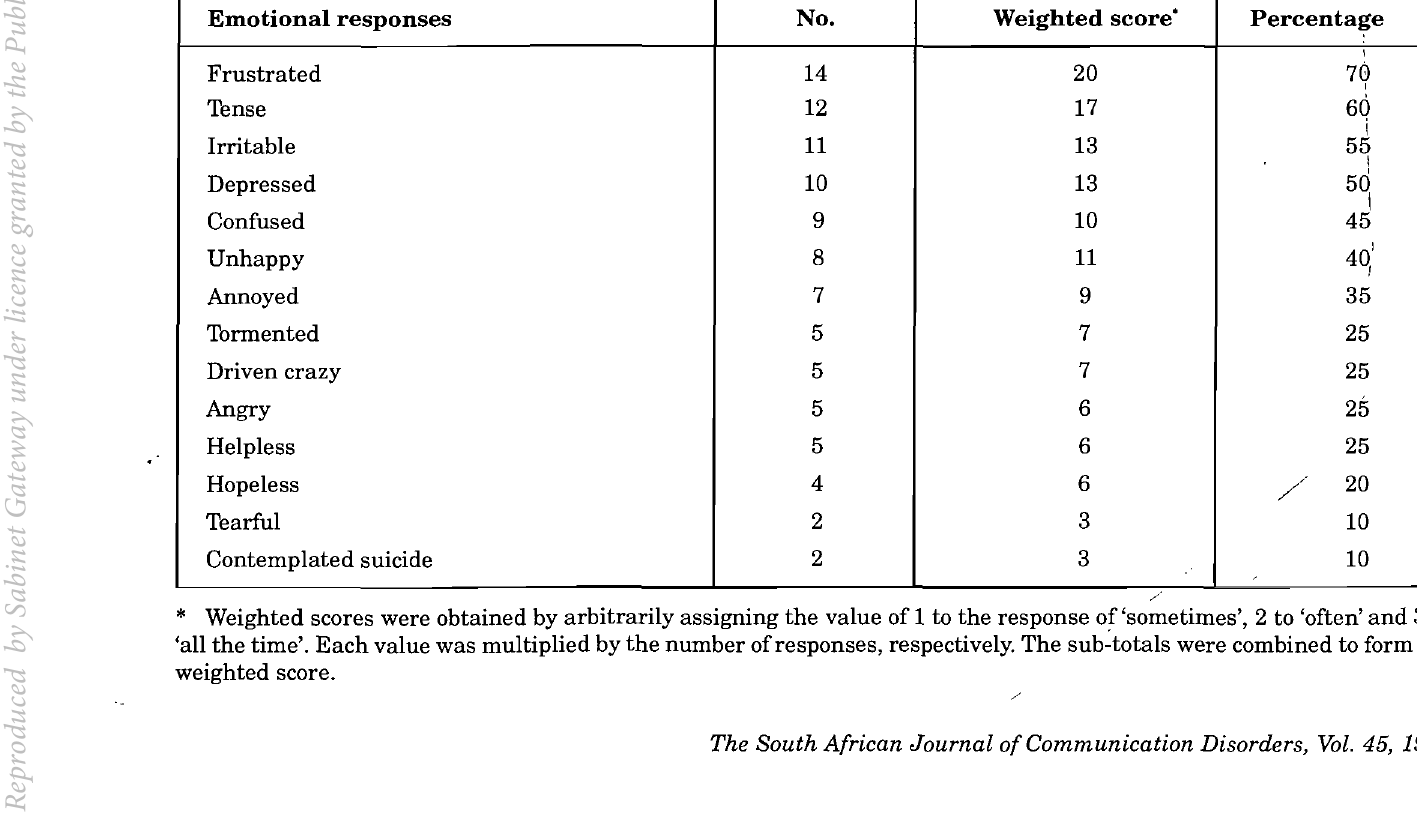
TABLE 4: Frequency with which emotional responses to tinnitus were experienced(N=20) Emotional responses